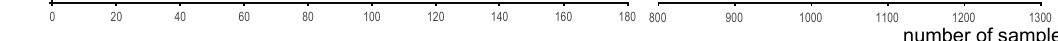
Figure 1. Statistics of “by-catch” plant DNA from leafhopper anchored hybrid enrichment datasets. ( a ) Number of different plant genes retrieved from anchored hybrid enrichment datasets. ( b ) Plant genes retrieved in the DNA samples extracted from different body parts. Plant DNA detection rates are indicated above bars. ( c ) Plant genes retrieved in each leafhopper subfamily. Plant DNA detection rates are indicated behind